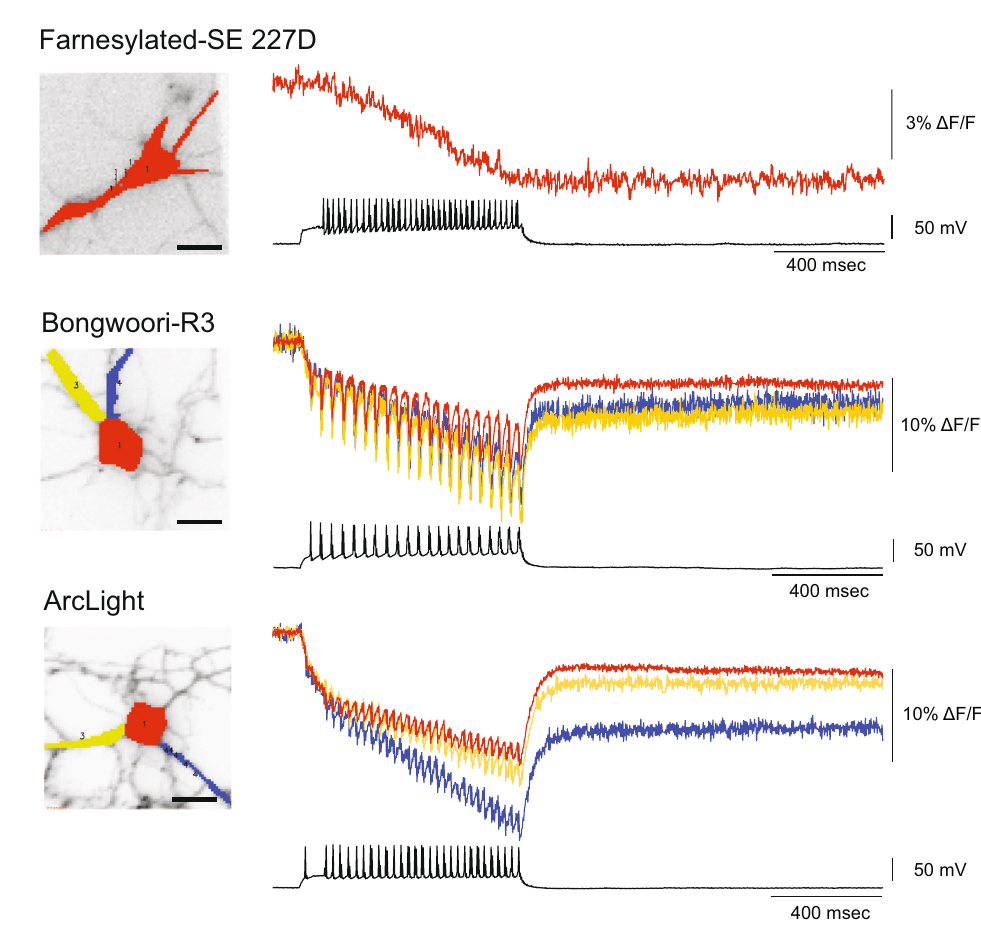
Figure 6. The baseline drift is due to the acidification of the neuron during the firing of action potentials. Cultured hippocampal neurons expressing a farnesylated version of the FP, SE 227D which is pH-sensitive, Bongwoori-R3, or ArcLight. To determine the role of pH induced fluorescent effects, a lipid-anchored version of SE 227D was expressed in hippocampal neurons and subjected to action potentials. The cultured hippocampal neuron expressing Bongwoori-R3 enables the optical resolution of action potentials and allows the comparison of the baseline changes in the soma to the processes. The neuron expressing ArcLight is also able to resolve action potentials and exhibits the baseline drift due to pH. Red trace is from the soma. Blue and yellow traces are from the processes. Scale bar = 20 µ